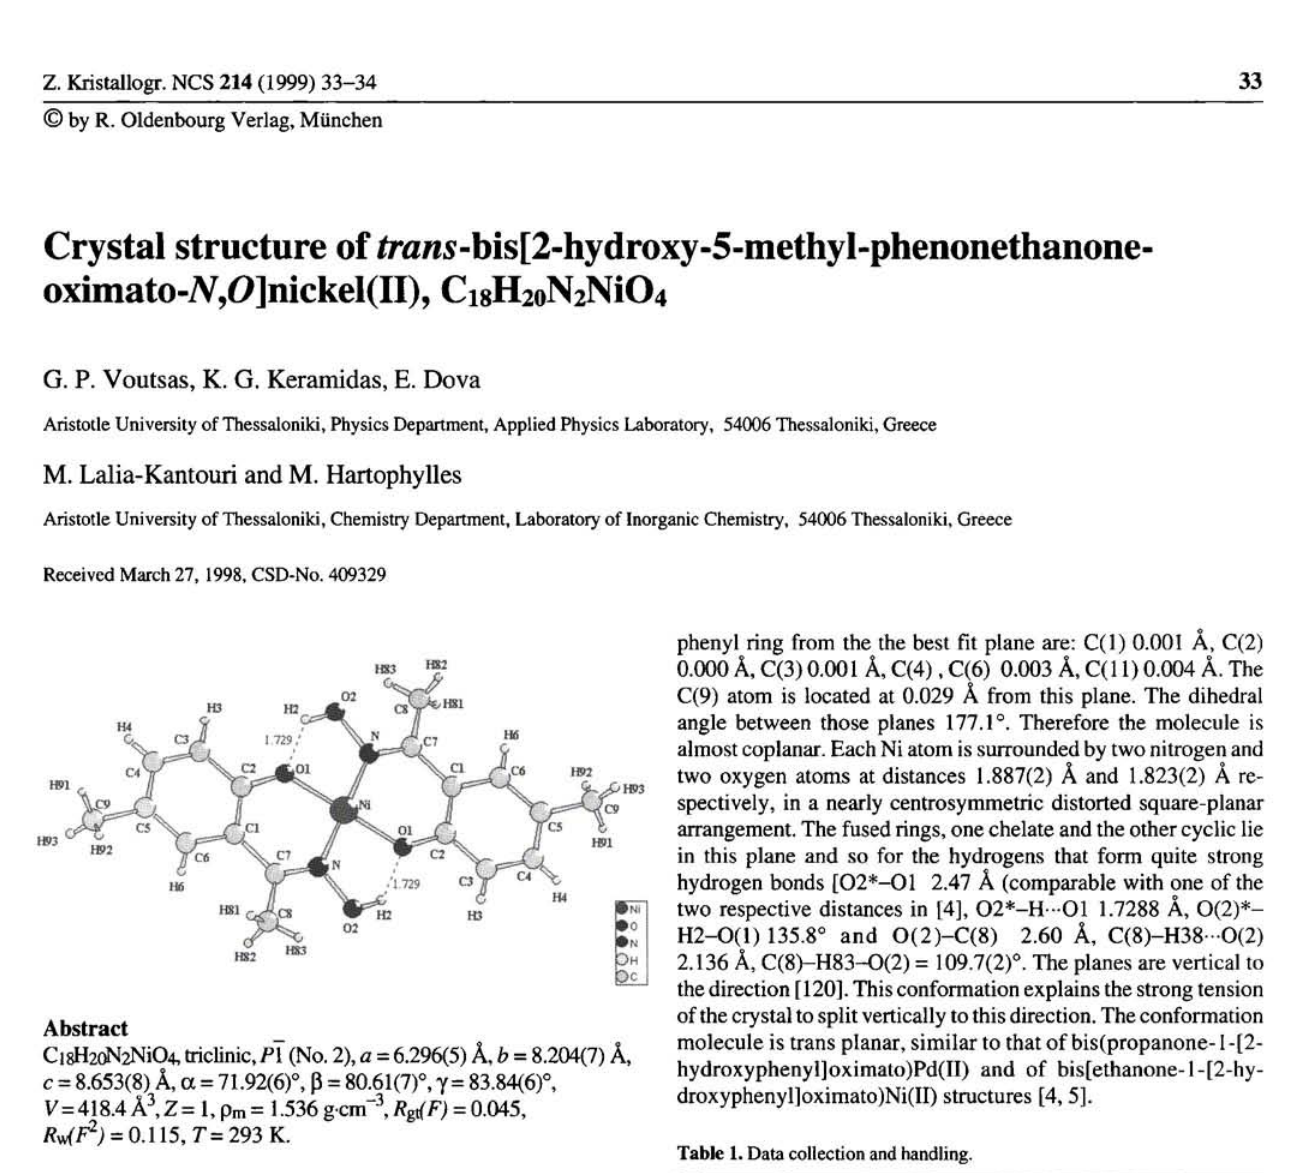
Table 1. Data collection and handling.